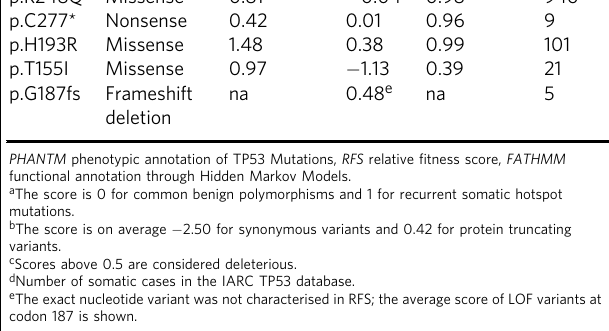
Table 1 Classi fi cation of TP53 mutations.